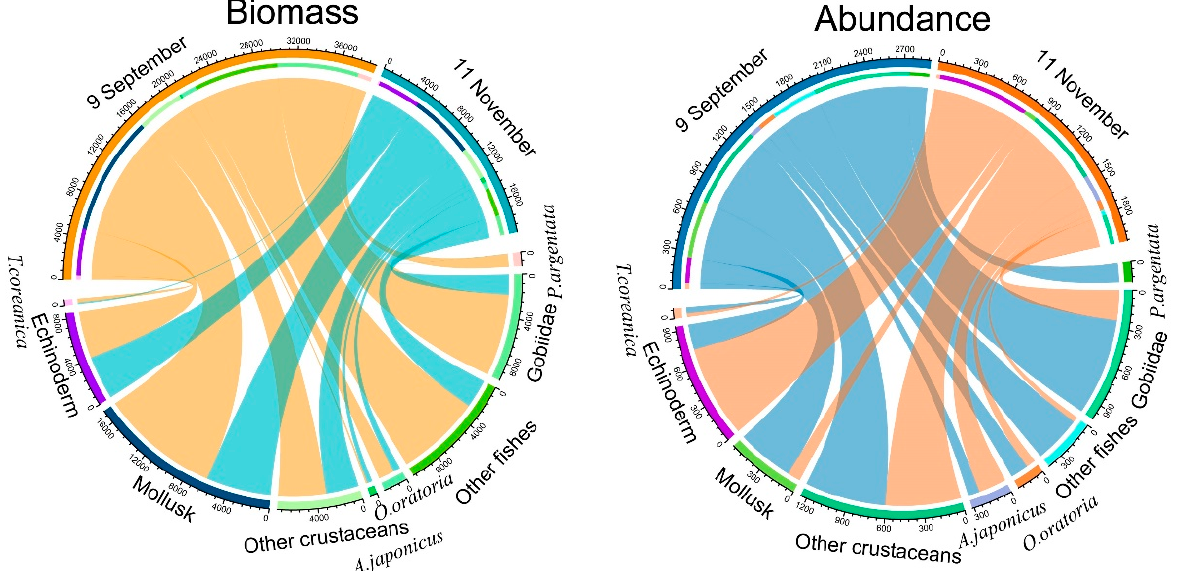
Figure 2. Bottom fishery community composition in September and November 2021. Biomass (g/10 min) on the ( left ) and abundance (Ind/10 min) on the ( right ).